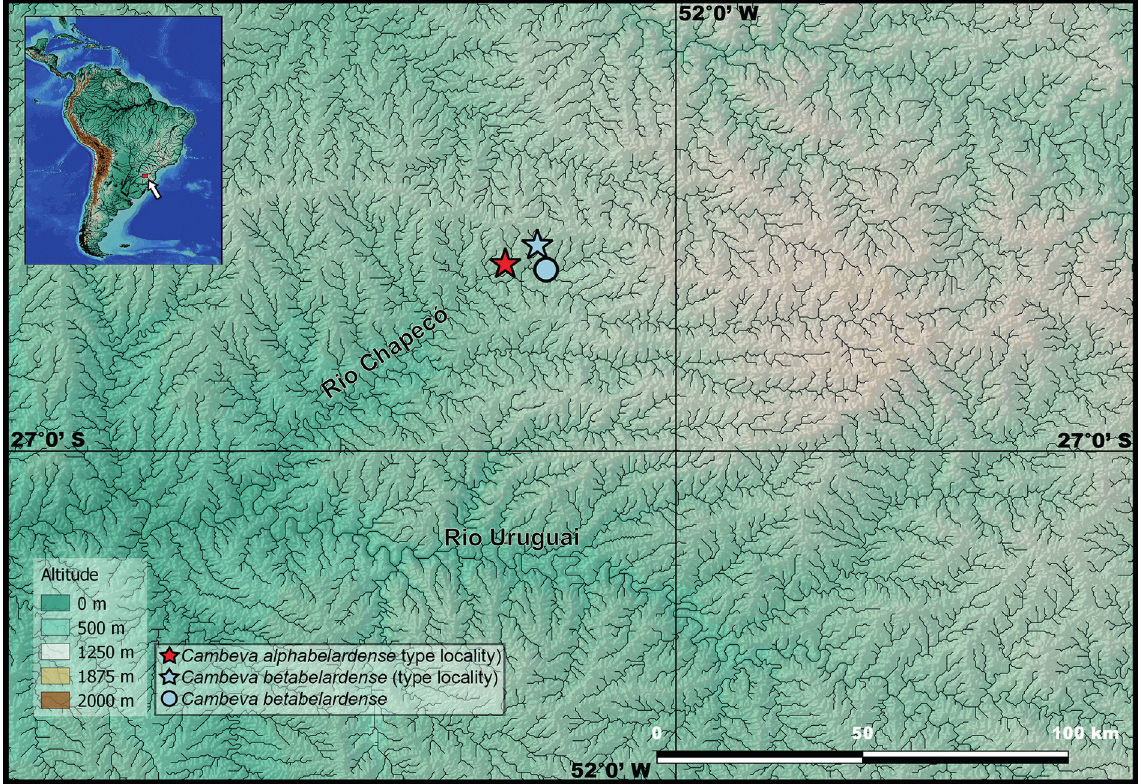
Fig. 3. Map of geographical distribution of Cambeva alphabelardense sp. nov. and C. betabelardense sp.